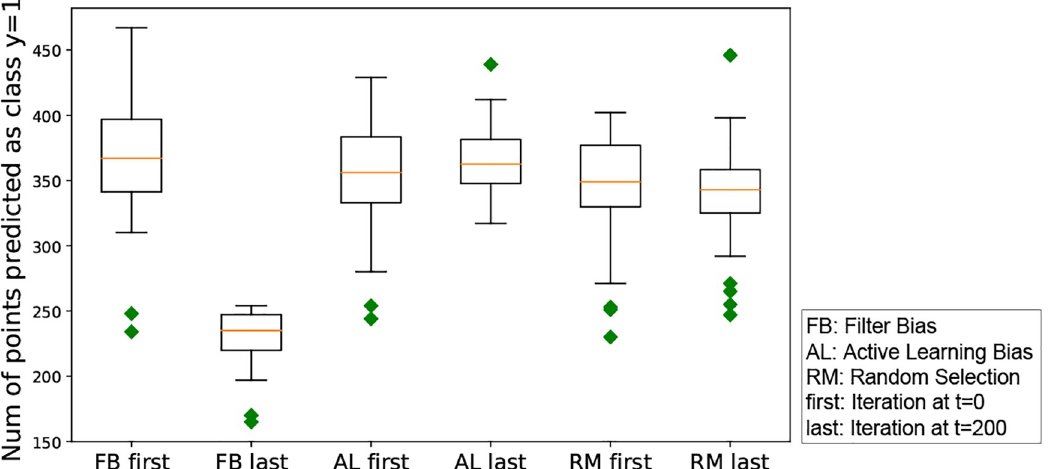
Fig 14. The box-plots showing the distribution of the number of points that are predicted to be in class y = 1 in the first and last iterations of the iterated learning for three iterated algorithmic biases with the MovieLens data set. Filter bias significantly decreases the number of points predicted to be in class y = 1. On the other hand, random selection and Active learning have no such significant effect.